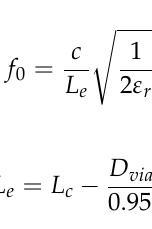
Figure 8. Simulated and measured radiation patterns of MTM-based wideband antenna at ( a ) 4.8 GHz, x - z plane, ( b ) 4.8 GHz, y - z plane, ( c ) 5.2 GHz, x - z plane, ( d ) 5.2 GHz, y - z plane.